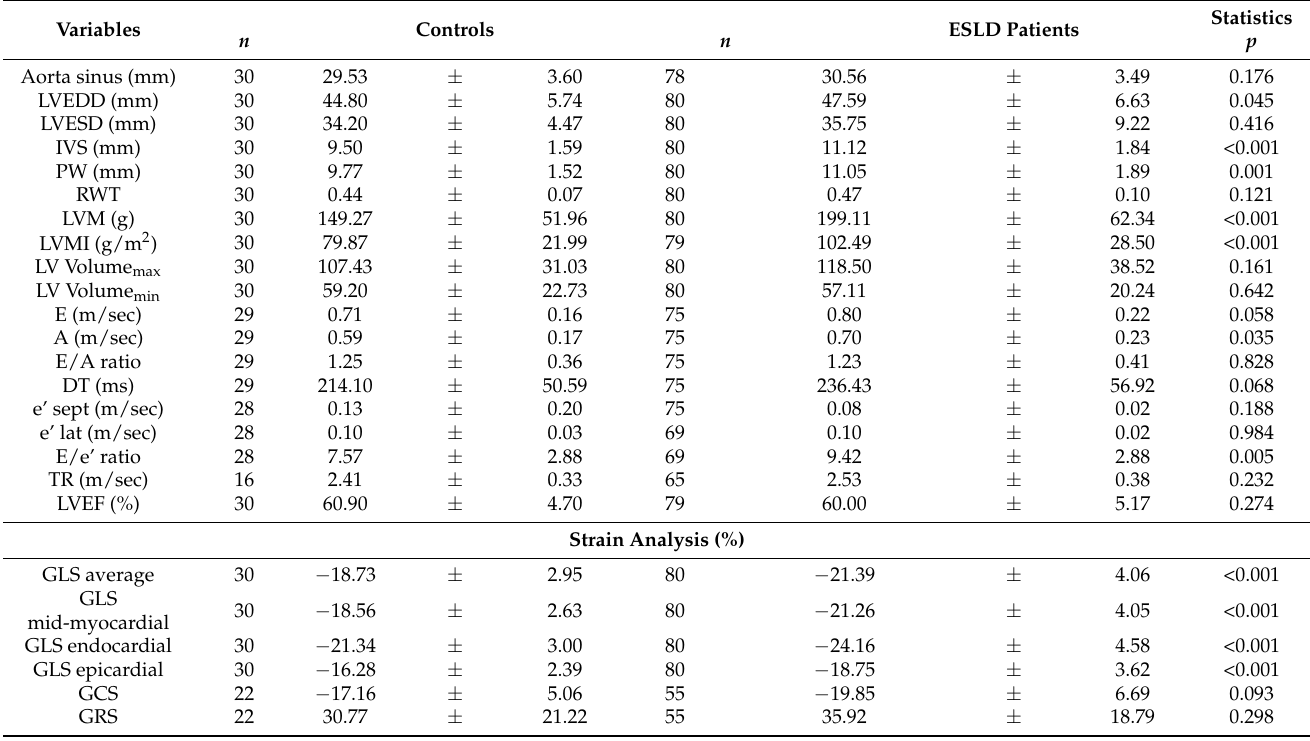
Table 2. Echocardiographic parameters of the left ventricle.